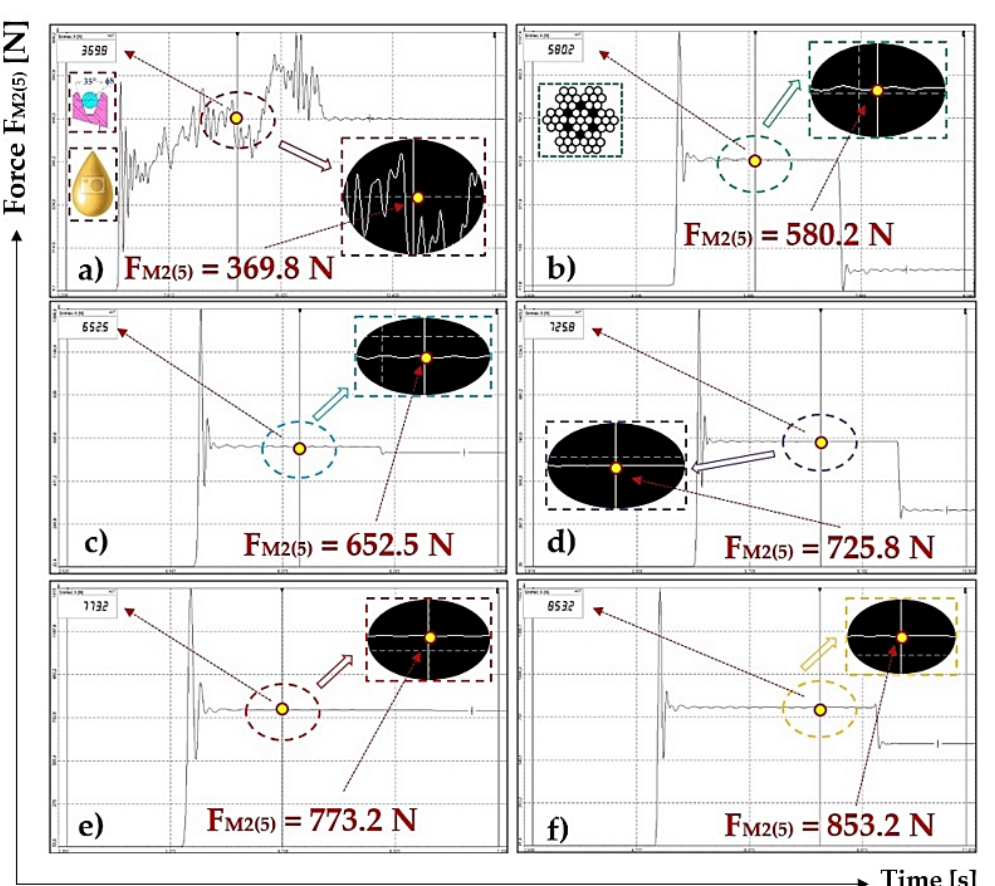
see Figure 13e, 10f see Figure 13f.